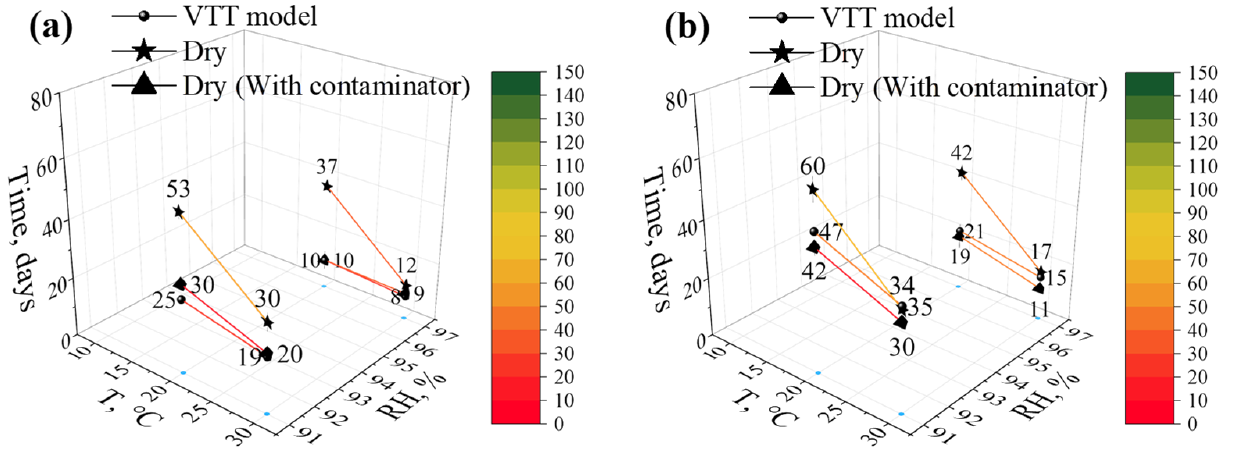
Figure 5. Influence of mould contamination on the time necessary reach ( a ) mould germination and ( b ) visible mould growth stages; ‘Dry’—no contamination, ‘Dry (with contaminator)’—with mould-infected object, VTT model—prediction by VTT model (spore suspension) [24]; light blue dots on the T and RH plane are the corresponding projections of the results.